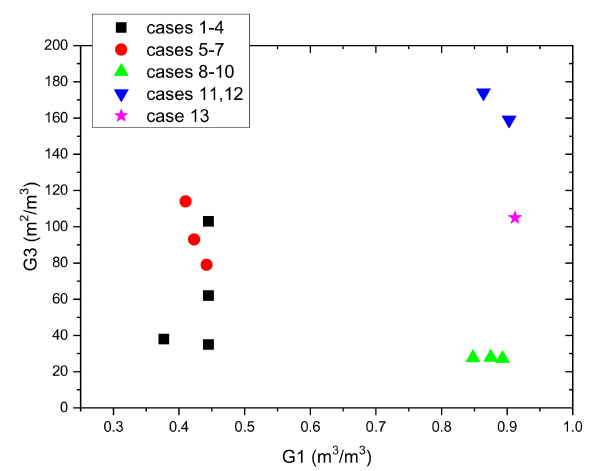
Figure 15. Comparison of analysed LHTES geometries based on G1 and G3 coefficients.